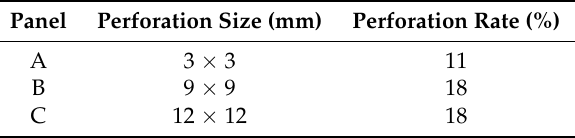
Figure 1. Model of the sound-absorbing perforated panels used for the numerical models [13]. Table 1. Perforated panels’ main characteristics [13].